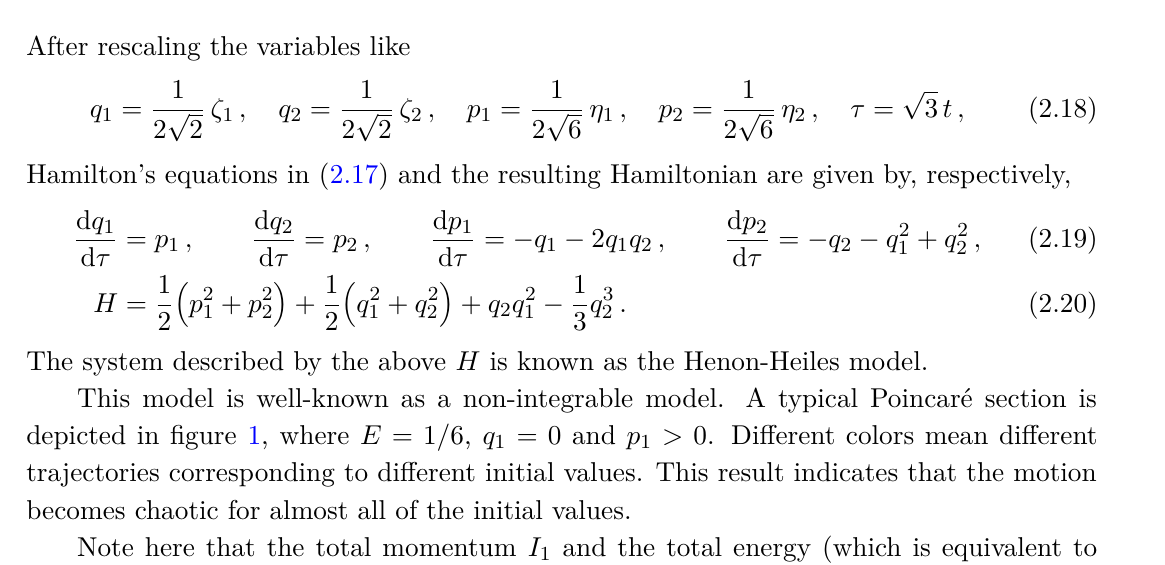
Figure 1. Poincaré section of the Henon-Heiles model with E = 1 / 6